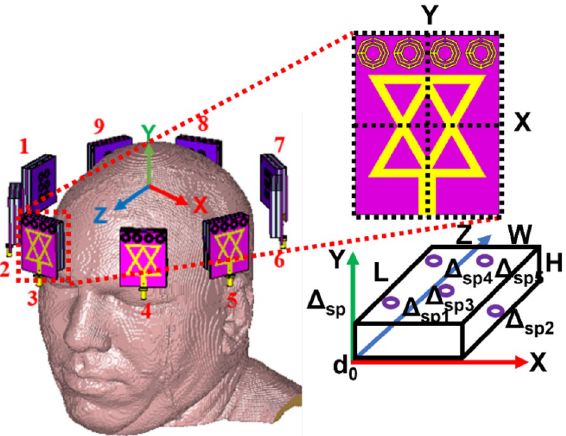
Figure 17. Arbitrary current and voltage picking point of stacked antenna and impedance matching scenario between antenna and Hugo model.